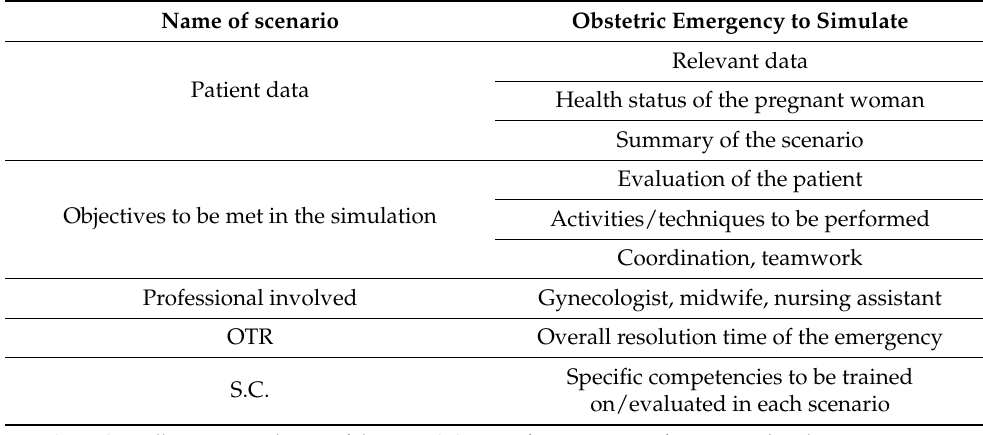
Table 2. Summary of the form for the training and evaluation of the